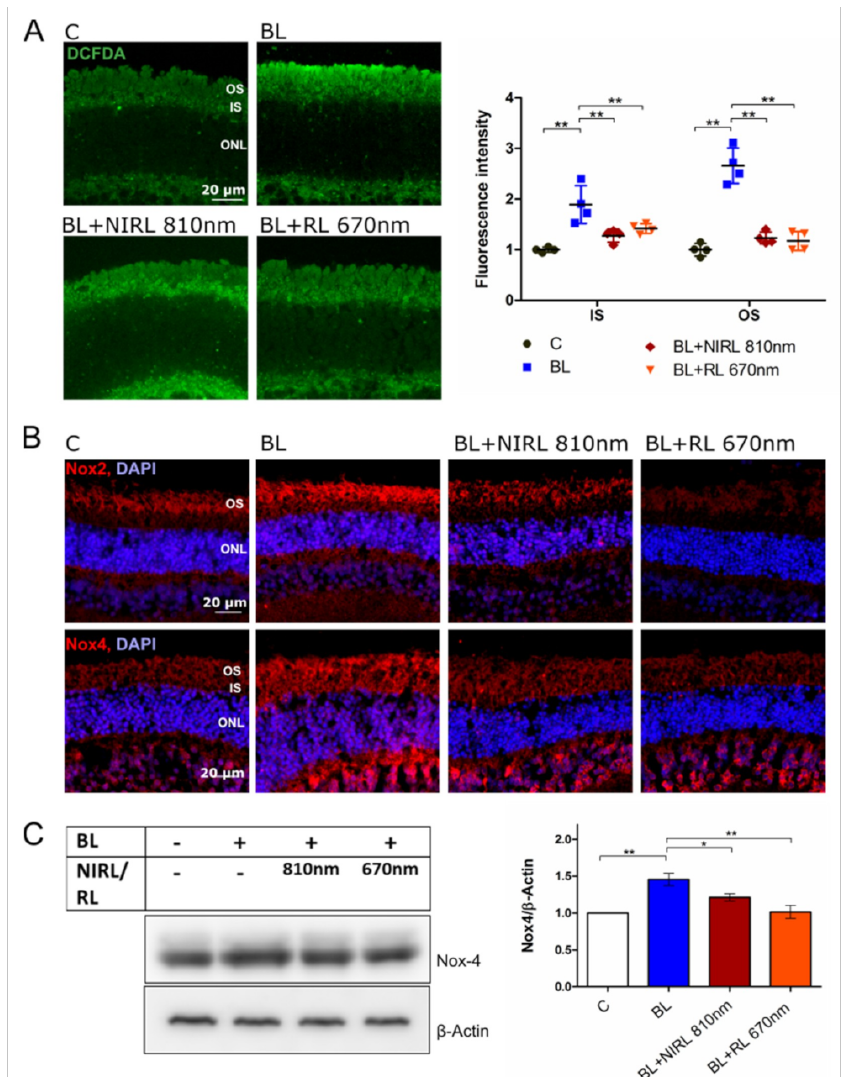
Figure 4. NIRL and RL induce reduced ROS production in BL irradiated cells. ( A ) Representative images of CM-H 2 DCFDA labeled unfixed retinal vibratome sections. Staining demonstrates ROS production in form of hydrogen peroxide (H 2 O 2 ), peroxynitrite anions (ONOO - ), hydroxyl radicals (HO . ) or peroxide radicals (ROO . ). Retinal layers: outer segments [OS], inner segments [IS], outer nuclear layer [ONL]. The graph displays fluorescence intensity of IS and OS normalized to Control (IS), demonstrating ROS production of n = 4 experiments ± SEM. Retinas were cultivated for 40 min (Control: 40 untreated, BL: 30 min BL + 10 min post-cultivation, BL + NIRL 810 nm: 30 min BL + 10 min 810 nm RL, BL + RL 670 nm: 30 min BL + 10 min 810 nm NIRL) for early event analysis. ( B , C ) Late event analysis after 9 h of cultivation. Eyes were treated for 6 h with BL, following 10 min NIRL or RL and post-cultivated for another 3 h. ( B ) Representative images of Nox2 and Nox4 immunohistochemical staining in retinal sections. N = 3 experiments. ( C ) Western blot analysis of isolated OS using antibodies against Nox4 and β -Actin as loading control. Protein level was quantified using ImageJ. N = 6 experiments ± SEM. * p < 0.05, ** p < 0.01 compared with